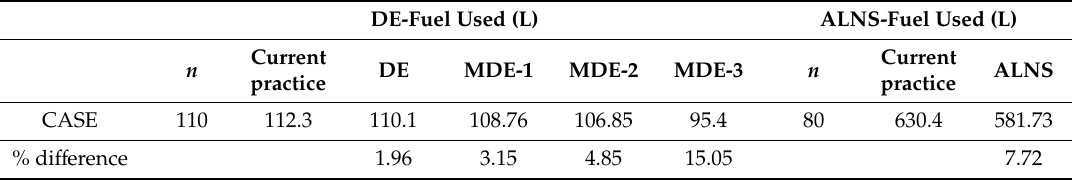
Table 12. Computational result of the DE and